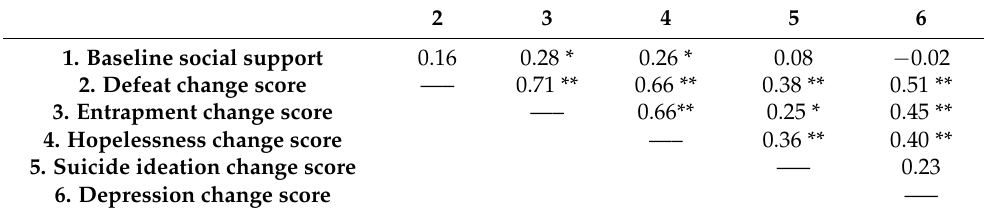
Table 2. Correlation coefficients for predictor variable, changes in the mediator/moderator variables, and the change in the outcome variable used in the regression model.